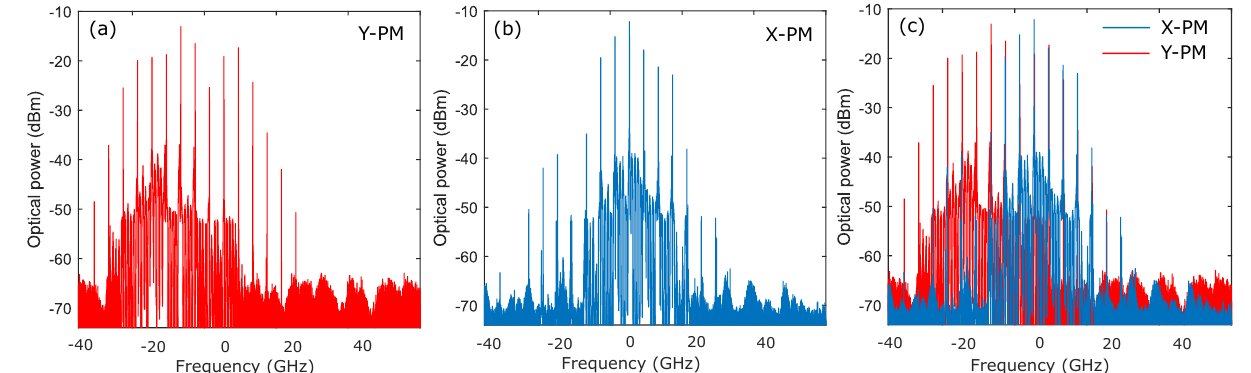
Figure 7. Polarization resolved-optical spectra corresponding to an example of two polarization comb dynamics in Figure 6e–i. ( a – c ) are obtained for detuning ∆ ν = − 0.9 GHz and injected power P inj = 432.8 µW. ( a – c ) correspond to the optical spectra of Y-PM, X-PM and the superposition of Y-PM and X-PM,